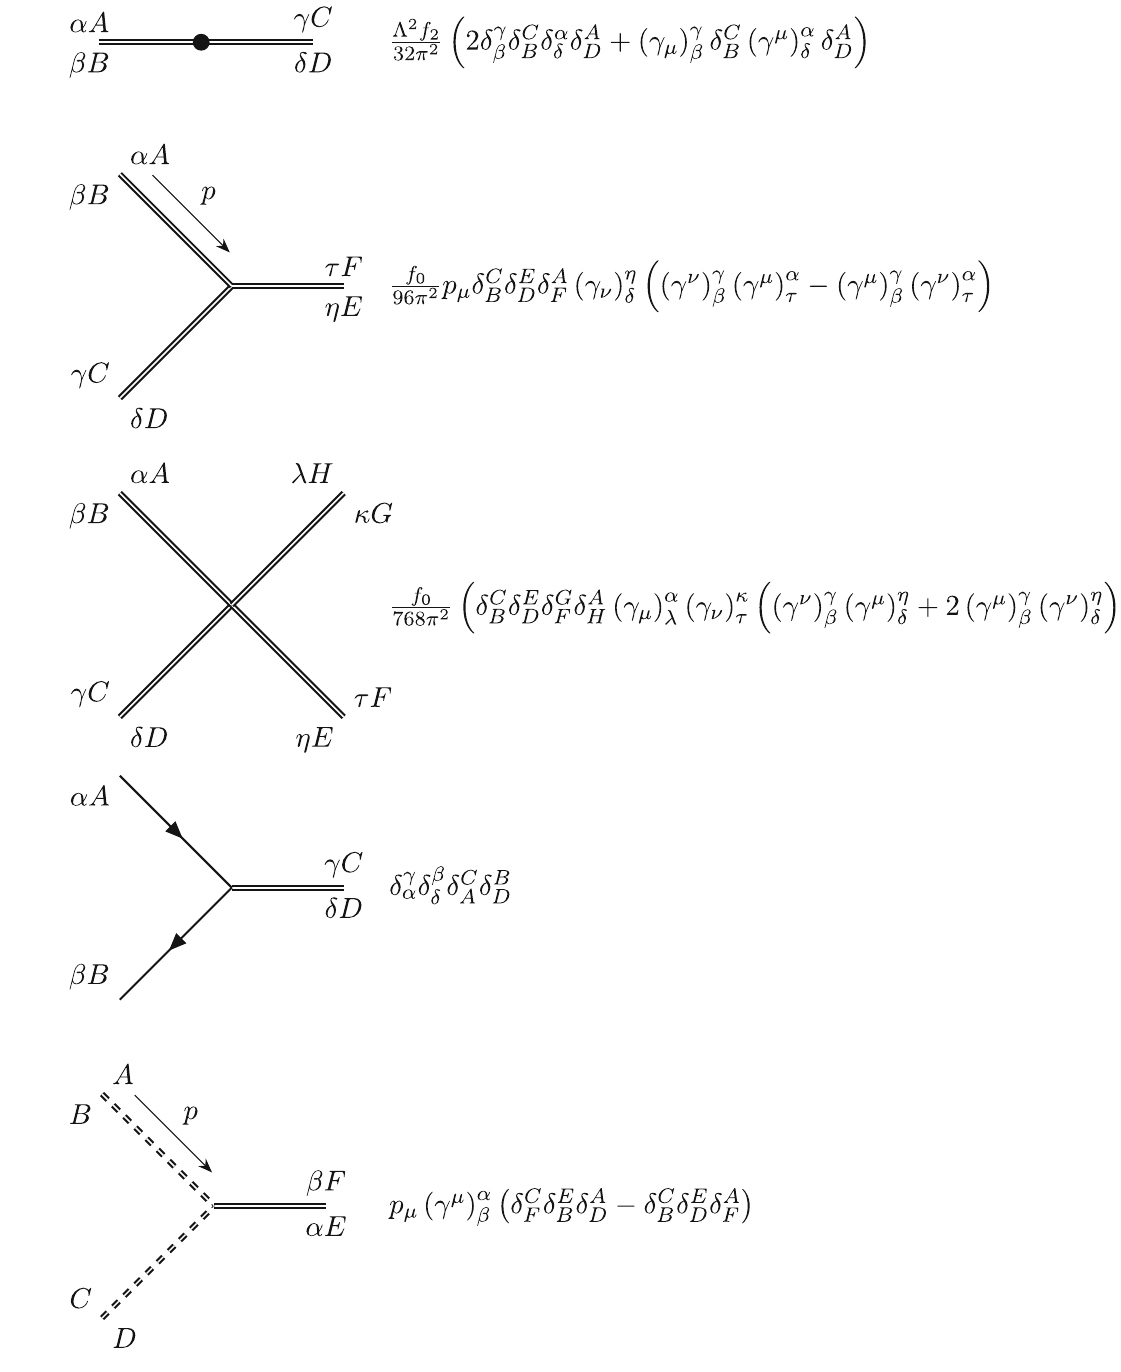
which can be written as (cid:2) (cid:3) (cid:2) (cid:3) (cid:2) (cid:3) γ κ α β B τ F γ μ γ ν γ μ δ C δ E δ G δ A (γ ν ) η A δ D γ A λ H κ 2 A η E δ A α A β τ λ C D G H B F so that the contribution to the vertex is (cid:2) (cid:3) (cid:2) (cid:3) (cid:2) (cid:3) γ κ α γ μ γ ν γ μ δ E δ G δ A (γ ν ) η 2 δ C δ β τ λ D H B F